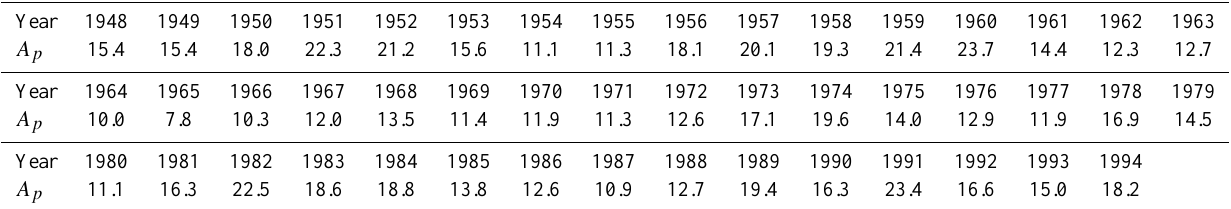
Table 1. The annual mean values of the A p index for the years considered in this